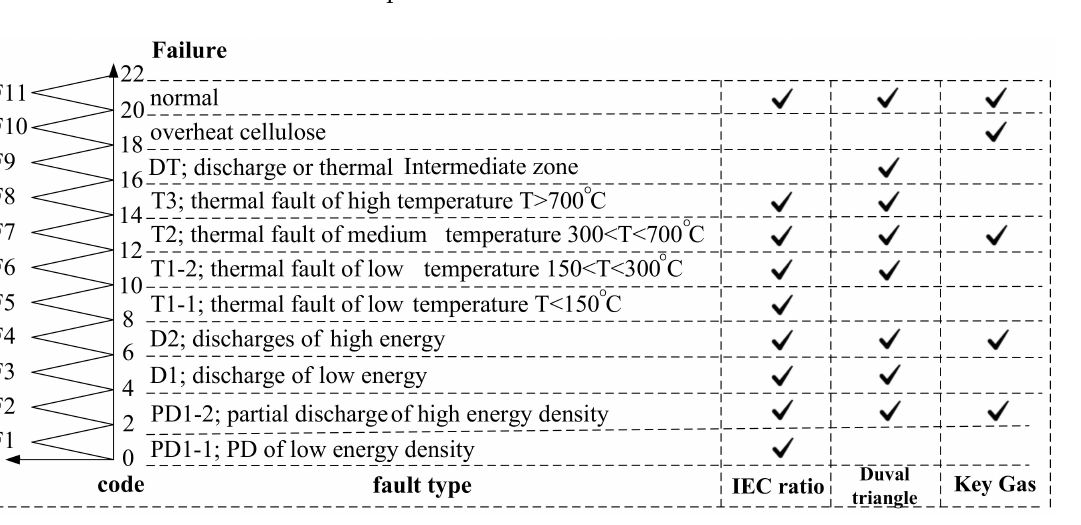
Figure 9. Fault types and fuzzy logic